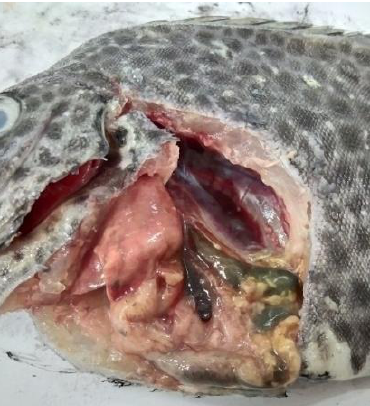
Figure 1. Representative example of hemorrhaging in the trunk kidney of Oplegnathus punctatus cultured in a fiber-reinforced plastic (FRP) tank.